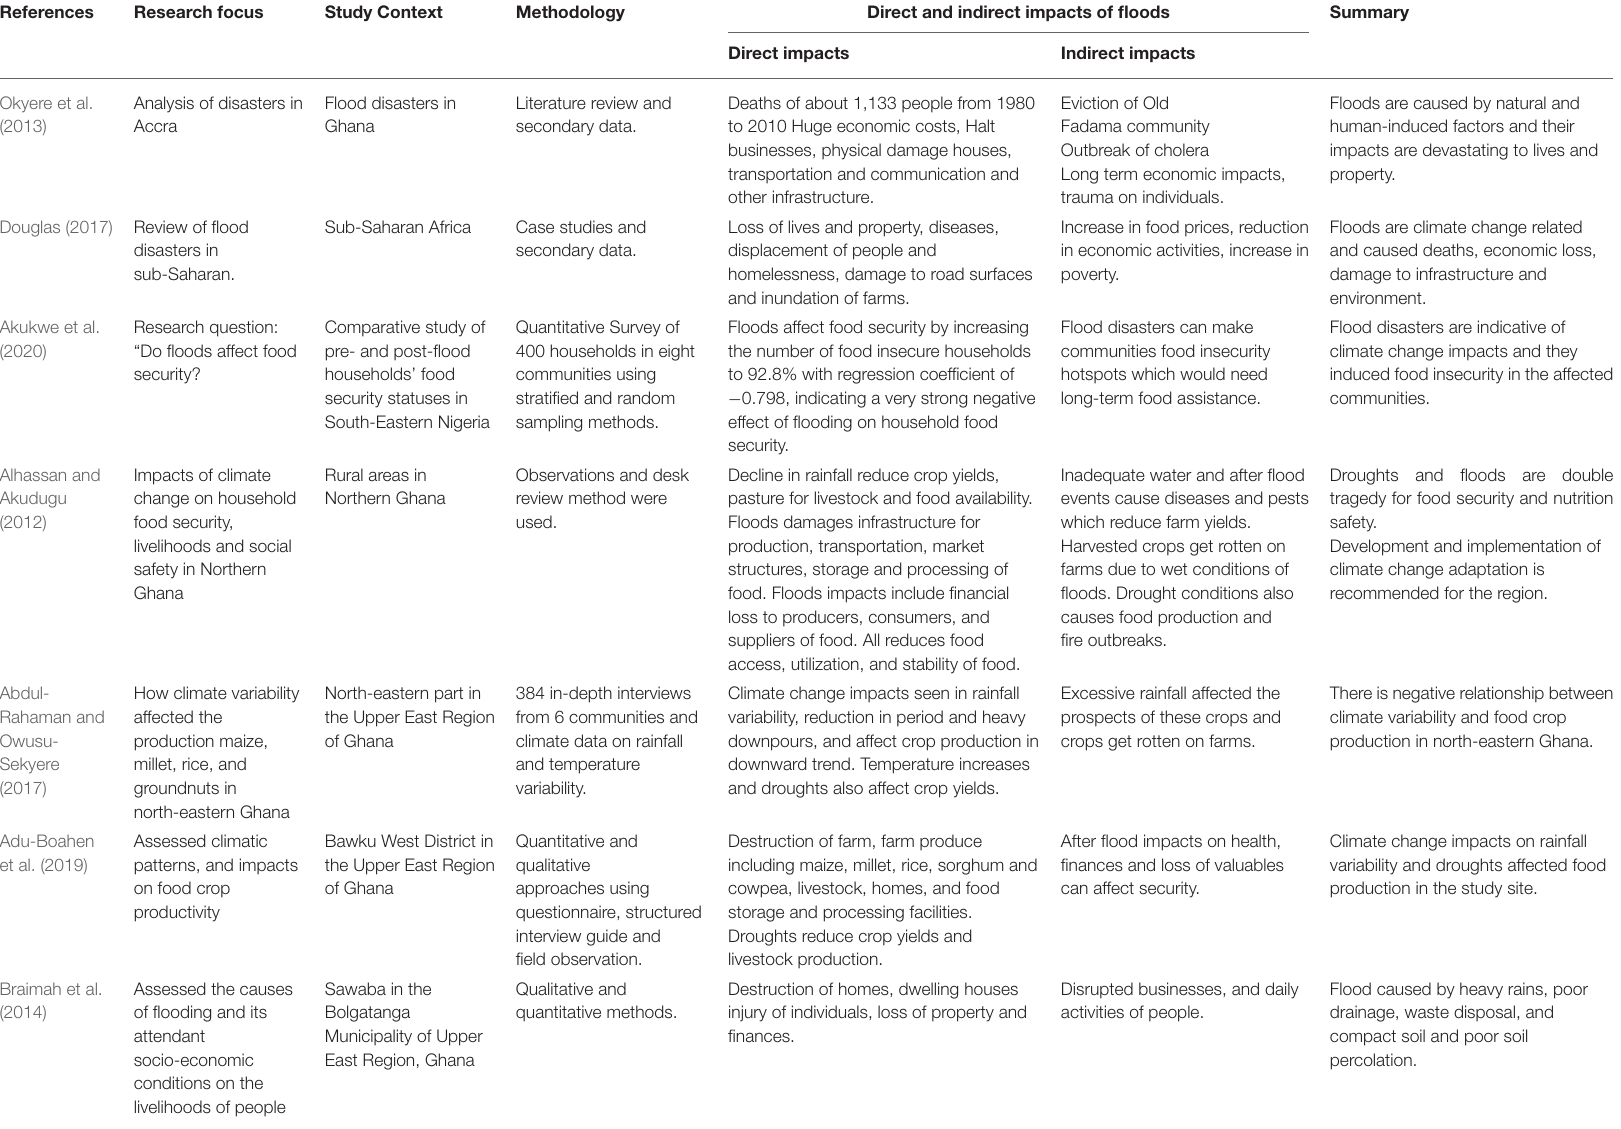
TABLE 1 | Summary findings climate change, and flood disaster impacts drawn from